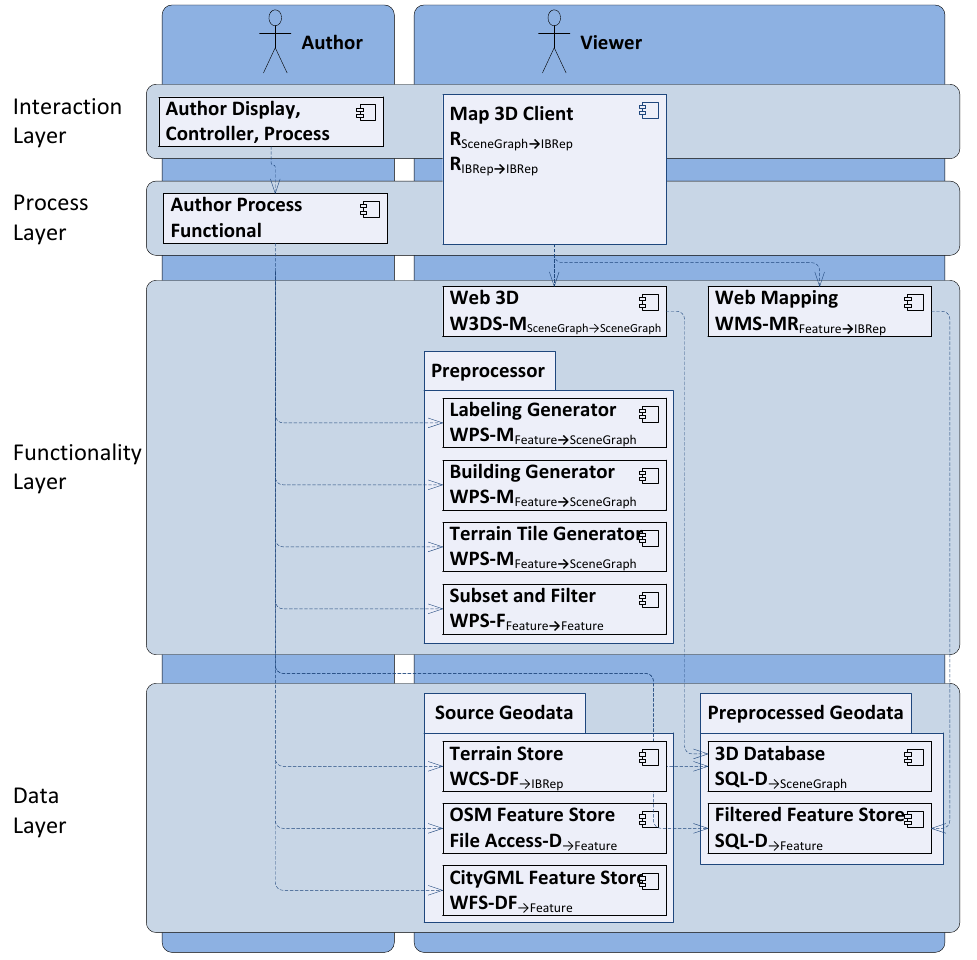
Figure 14. Overview of the logical software architecture of an existing 3DGeoVS [29,33]. The diagram omits elements not directly concerned with visualizing